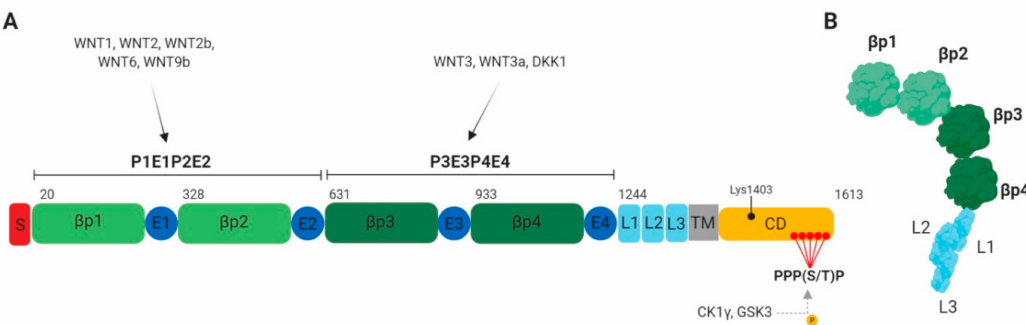
Figure2. LRP6structure. ( A )SchematicrepresentationofhumanLRP6domains: β p, YWTD β -propeller domains; CD, cytoplasmic domain; E, EGF-like domains; L, LDLR type A repeats; S, signal